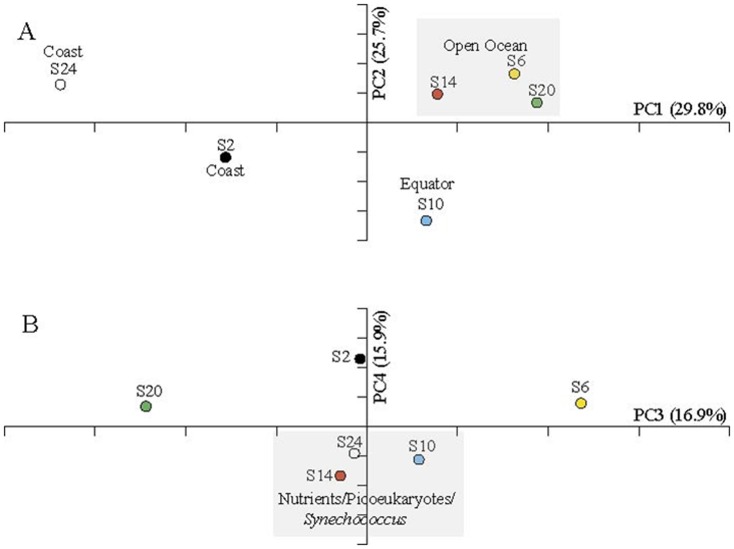
Principal Coordinates Analysis (PCoA) of marine fungal community based on the weighted-UniFrac distance matrix.Fungal communities from different locations were indicated as different symbols. The percentages of variation at the first four major coordinates were indicated. A. Fungal community variation explained by coordinates PC1 and PC2; B. Fungal community variation explained by coordinates PC3 and PC4.